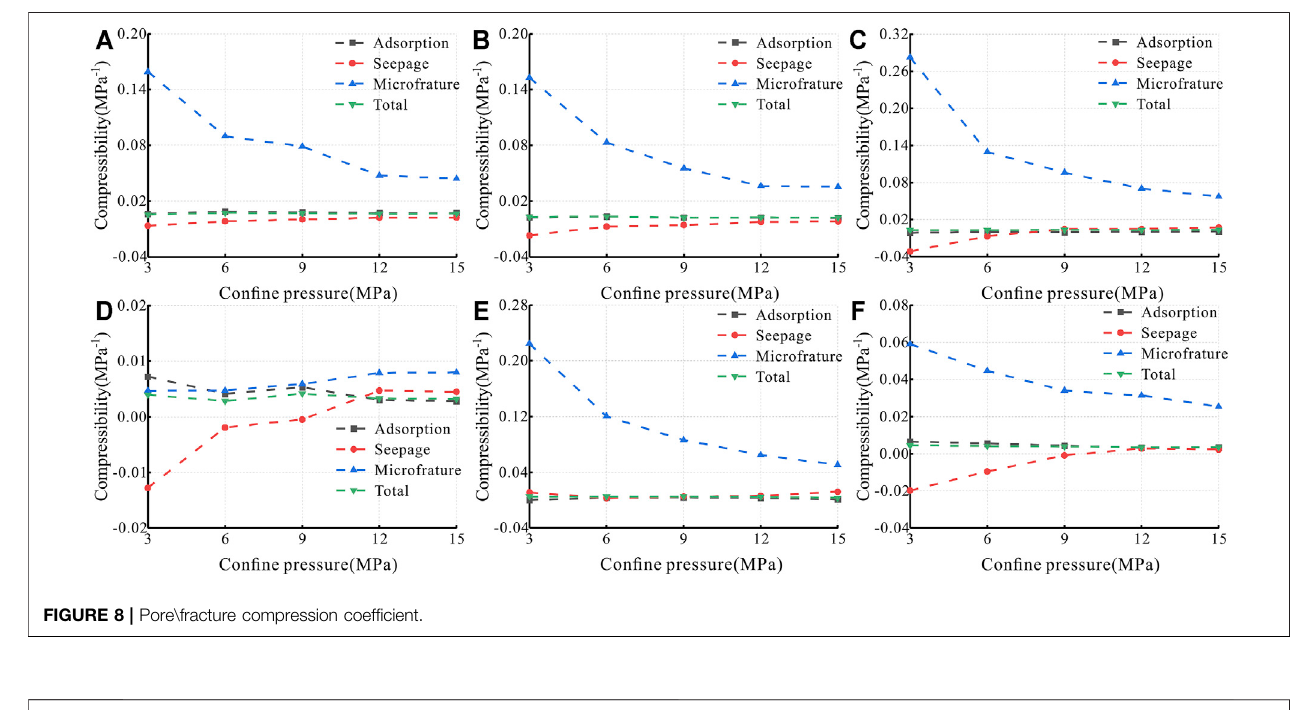
FIGURE 8 | Pore\fracture compression coef fi cient.